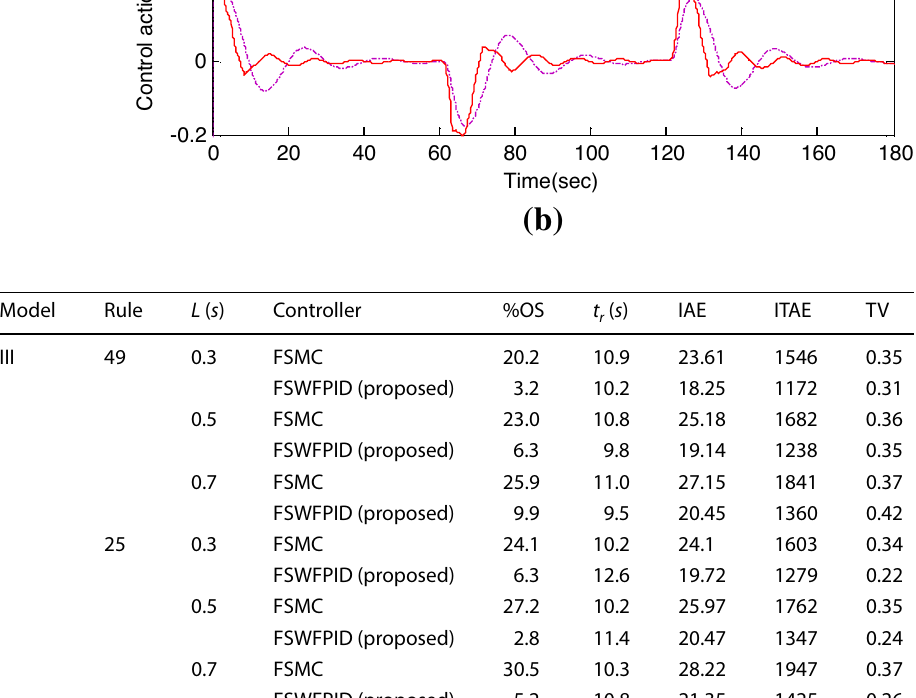
Table 11 Performance analysis for Model